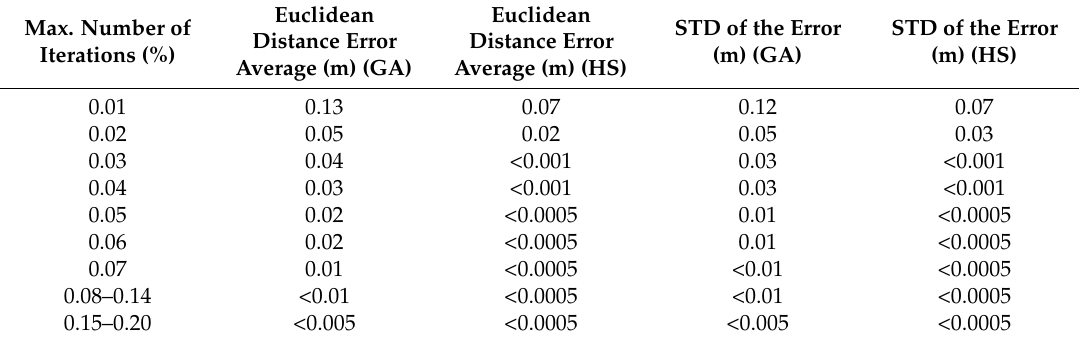
Figure 6. Study of the error based on the Euclidean distance and the standard deviation (STD) for the calibration of a beacon according to several numbers of iterations represented by a percentage of possible combinations to solve the problem, comparing GA and HS methods. Table 3. Detailed results of the study of the maximum number of iterations needed for GA and HS methods.